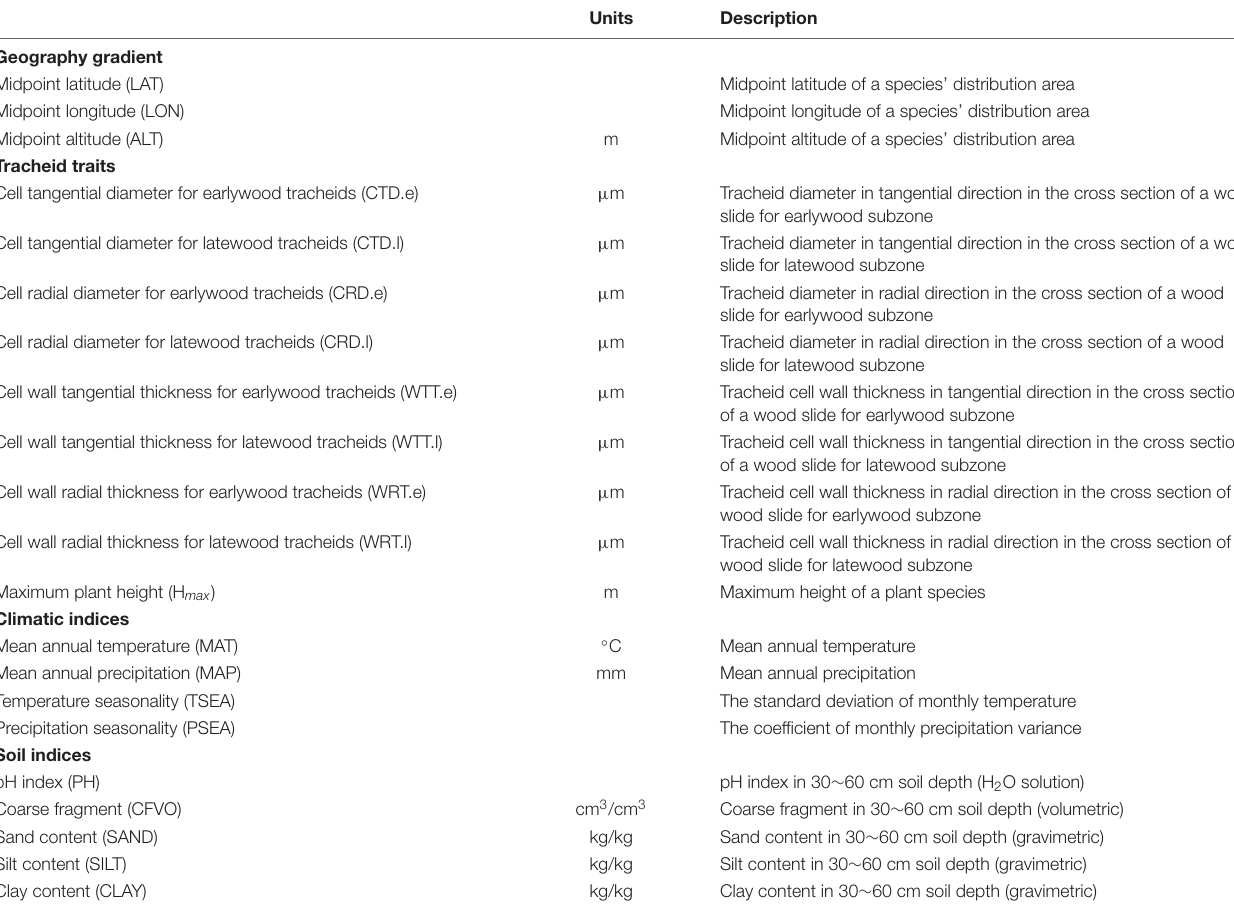
TABLE 1 | Traits and environmental factors examined in this study, with reference to their acronyms, units, and